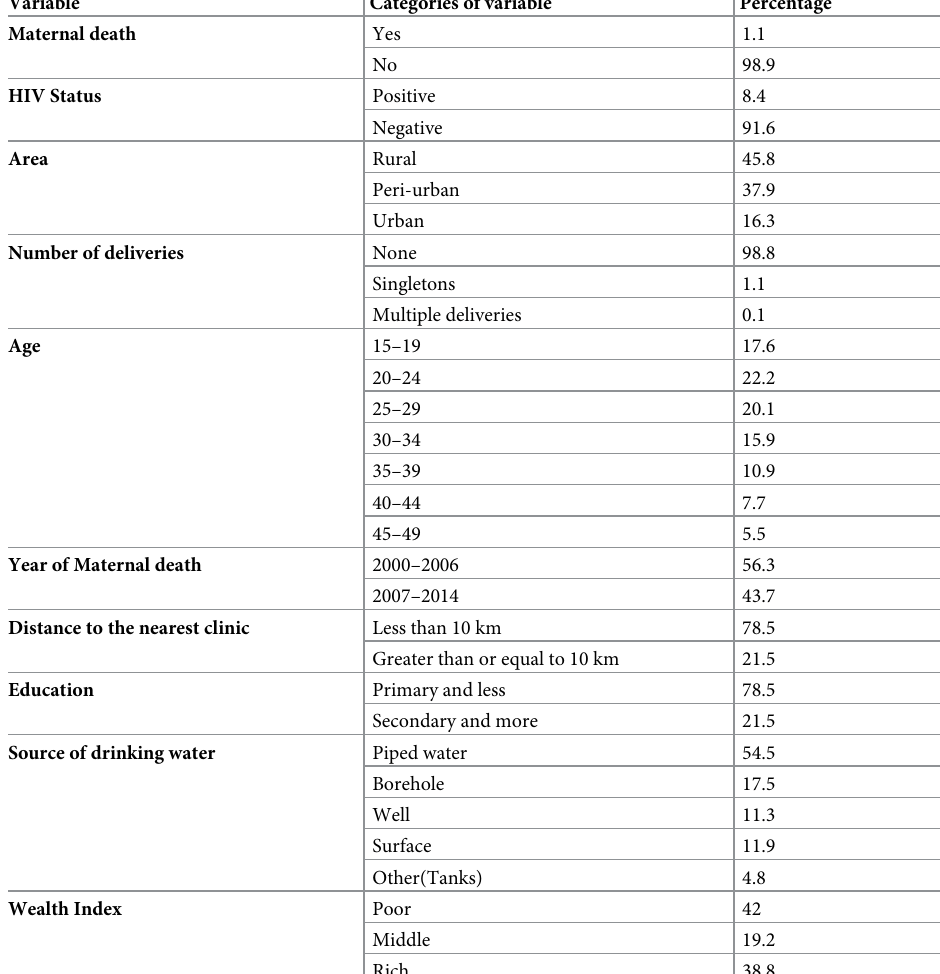
Table 1. Demographic characteristics of women of child bearing age (15–49) in Africa Health Research Institute, South Africa